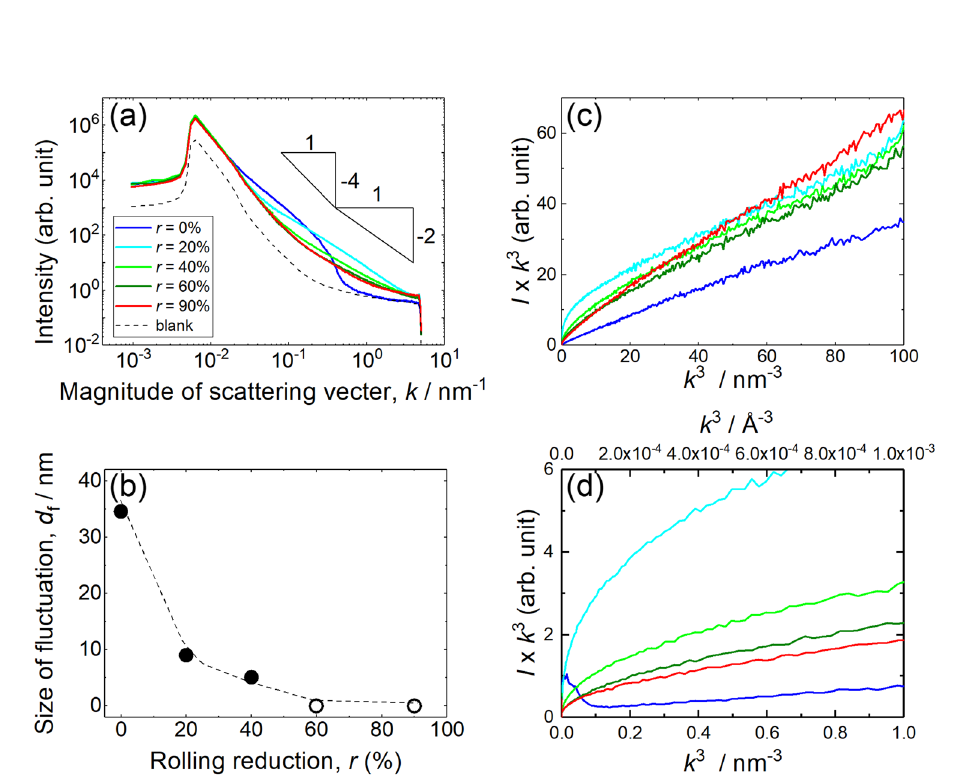
Figure 3. Rolling reduction dependence of ( a ) scattering intensity versus magnitude of scattering vector for SAXS and ( b ) size of fluctuation evaluated from SAXS. The triangles in ( a ) represent the gradient of k − k − 2 . It is noted that white filled circles in ( b ) represents that the size of fluctuation is too small to be measured by SAXS. It is noted that the blank curve is shown as a reference. ( c ) I × k atomic HEA and ( d ) magnified plot close to the original point of ( a